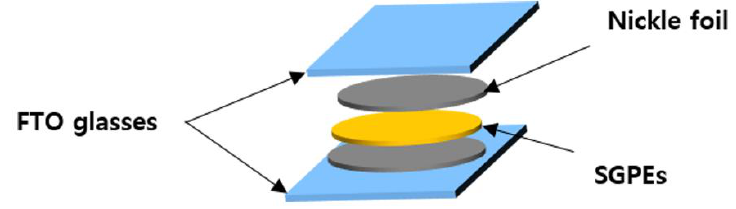
Figure 2. Illustration of the homemade cell assembly.